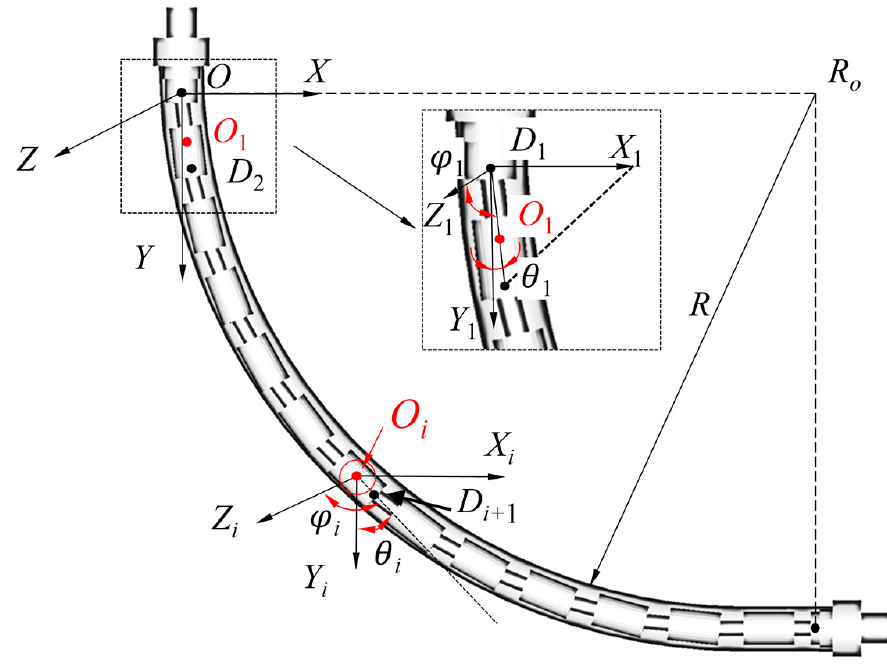
Figure 5. Local coordinate system of the universal joint.